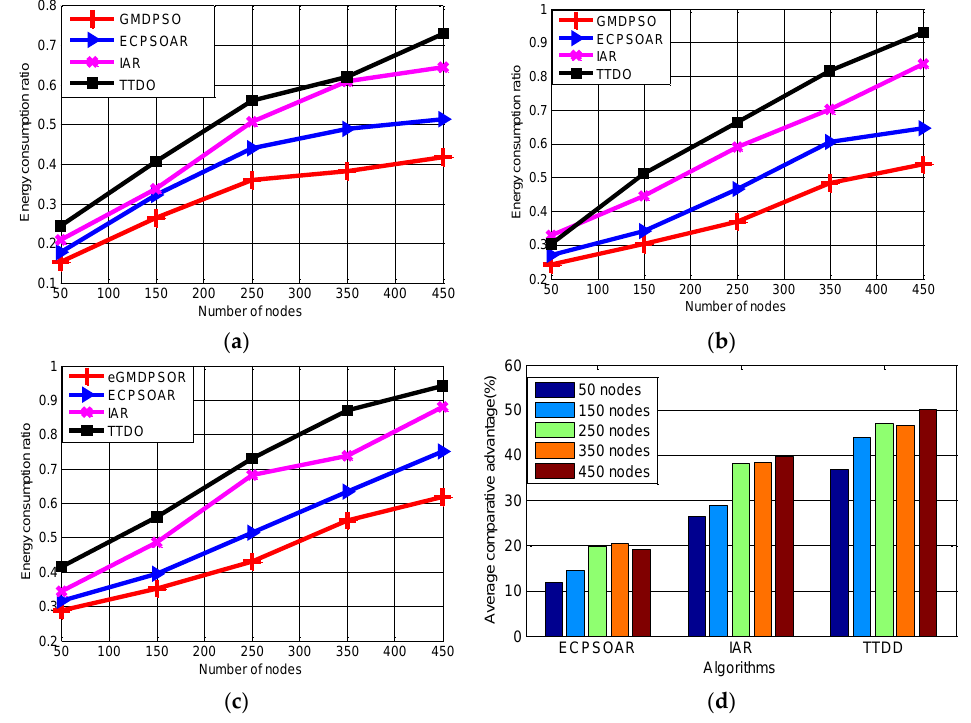
Figure 9. Average energy consumption ratio (ECR) with respect to different speeds of mobile sinks. ( a ) When the moving speed of sinks is 5 m/s; ( b ) When the moving speed of sinks is 10 m/s; ( c ) When the moving speed of sinks is 20 m/s; ( d ) Average ECR comparative advantage. Table 6. Average ECR with respect to different 𝑉 𝑆𝑖𝑛𝑘 .